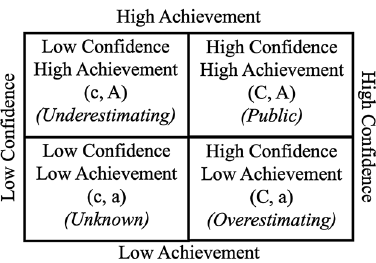
FIG. 1. CCL Confidence achievement window